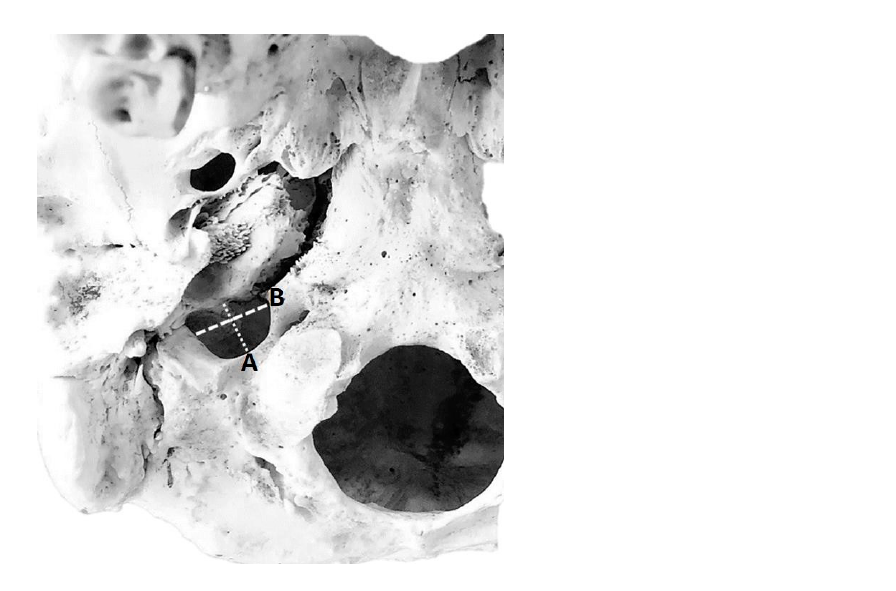
Figure 3. Measurements of jugular foramen parameters: ( A ) anteroposterior diameter of the jugular foramen, ( B ) mediolateral diameter of the jugular foramen .